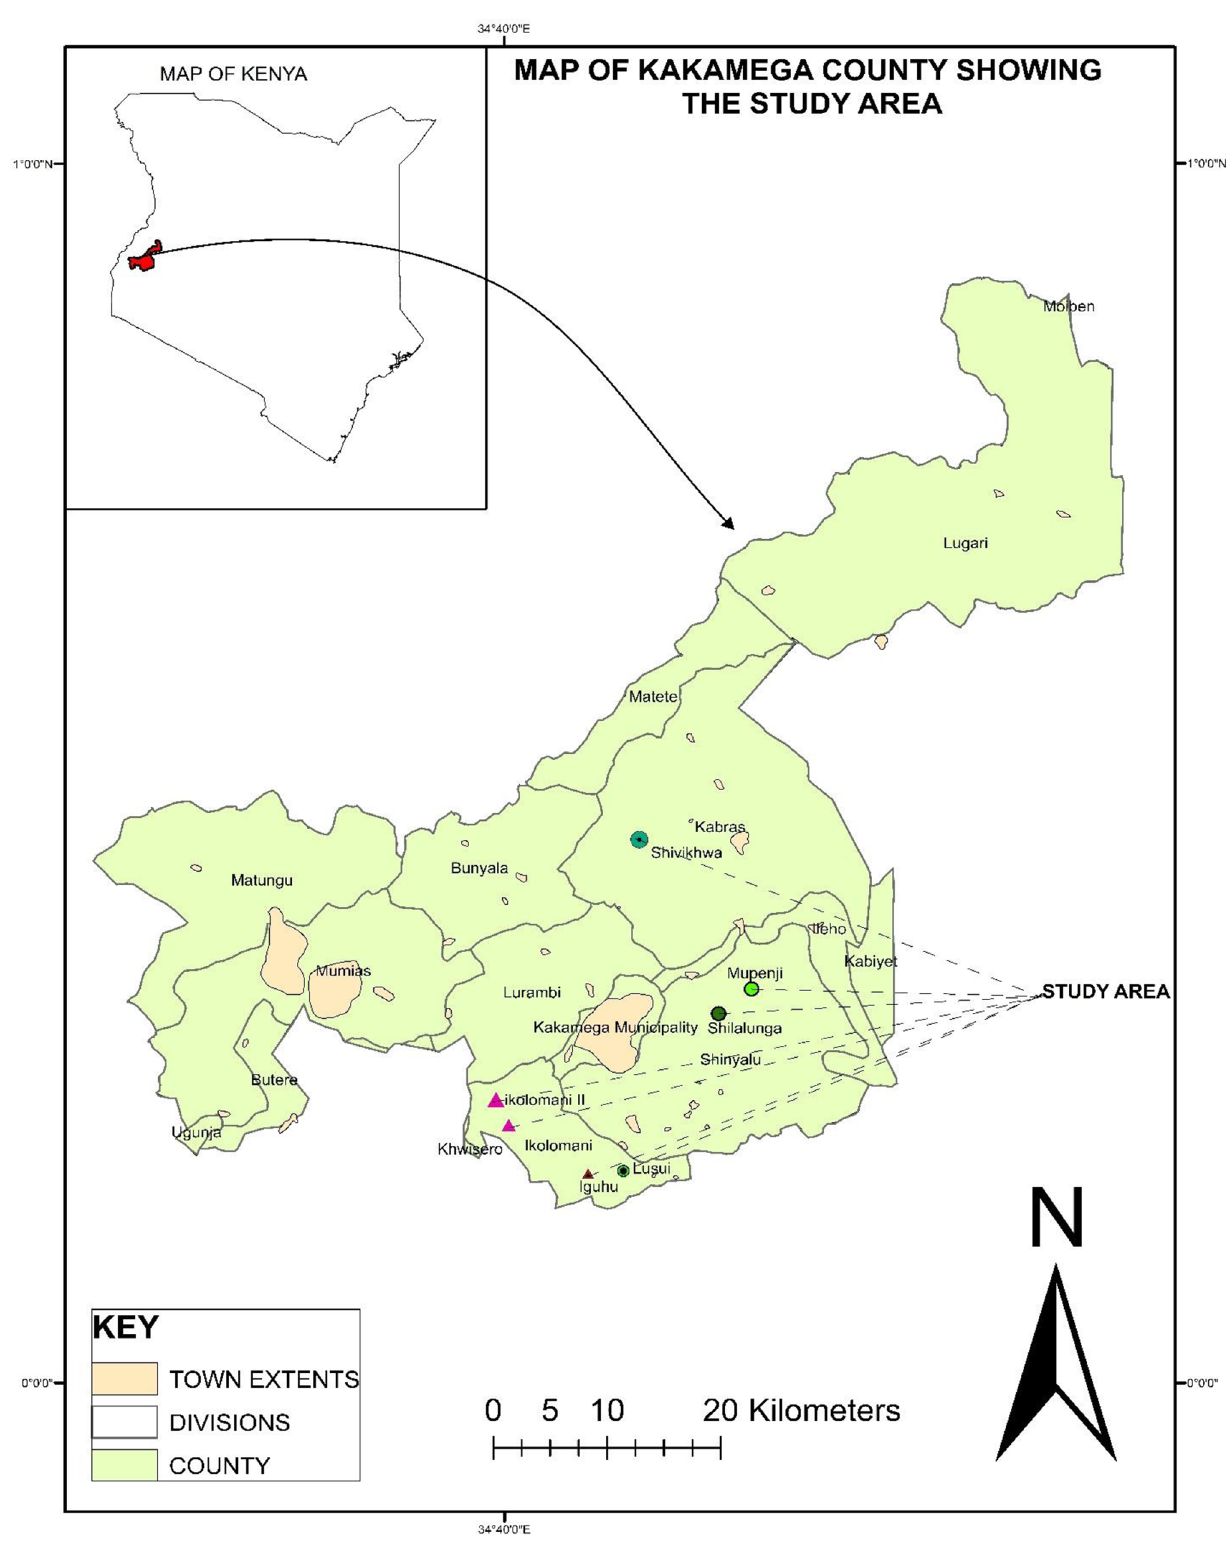
Fig. 1 The research area: Kakamega